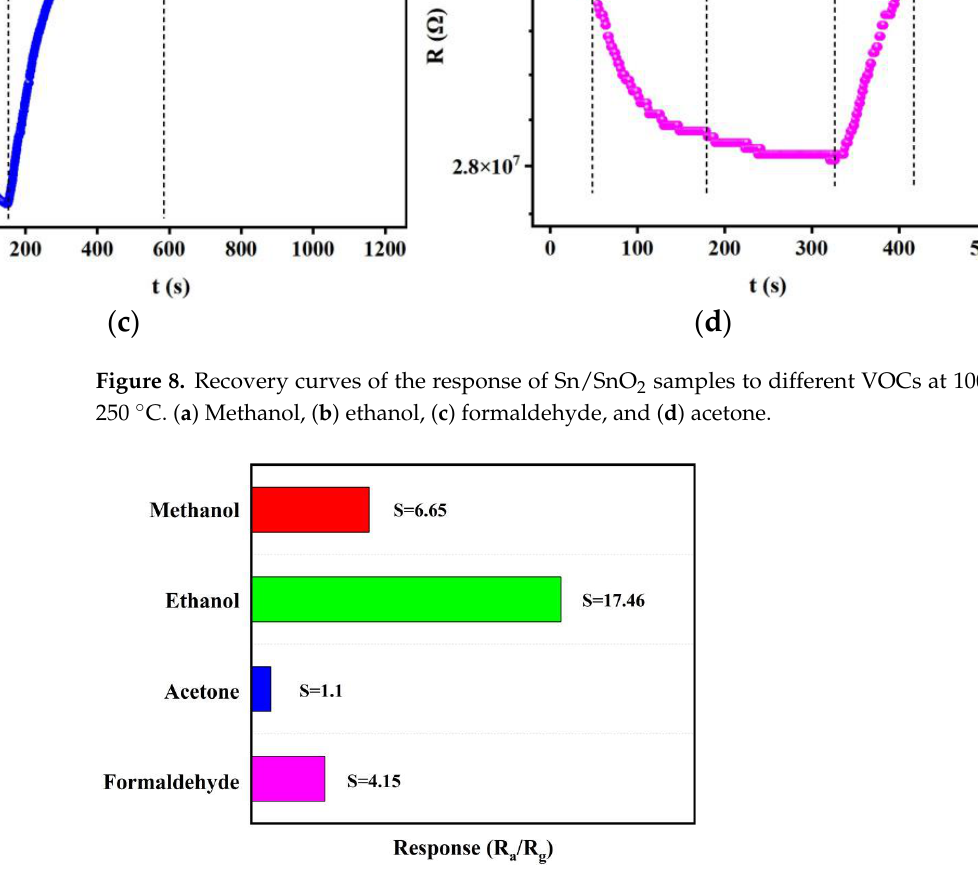
Figure 9. Gas response of Sn/SnO 2 sample to 1000 ppm of different VOCs at 250 °C.